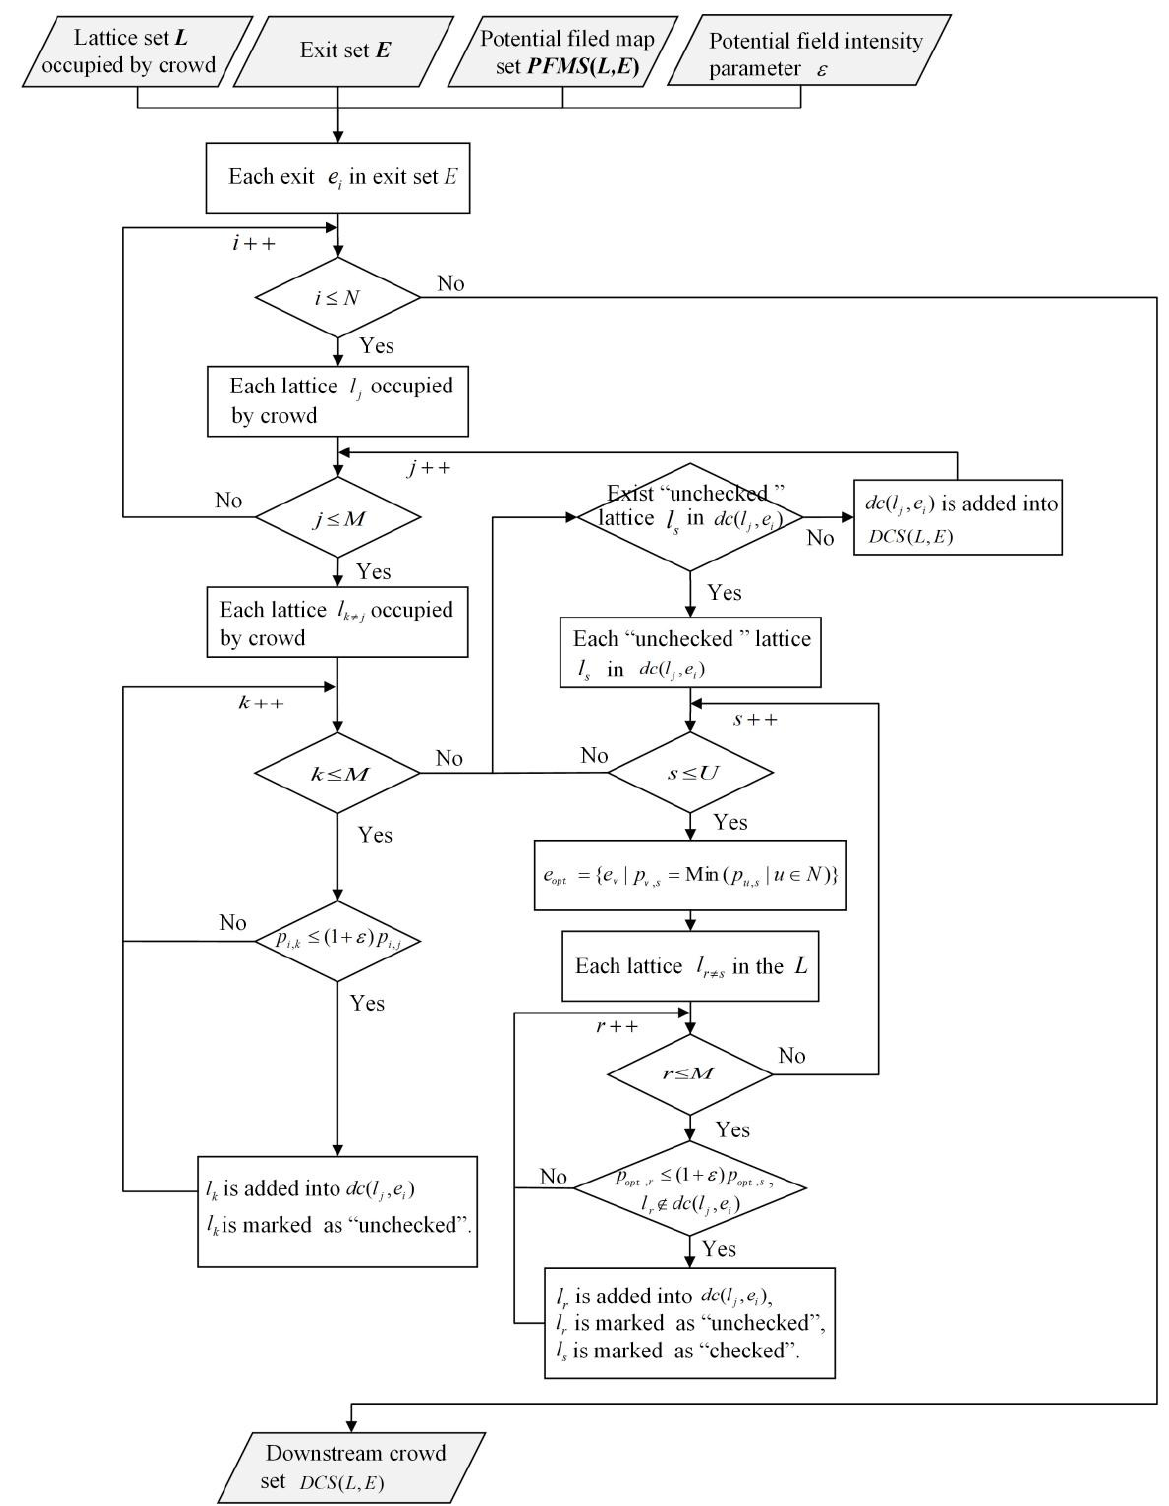
Figure A2. Flowchart of individual’s downstream crowd identification based on potential field map.